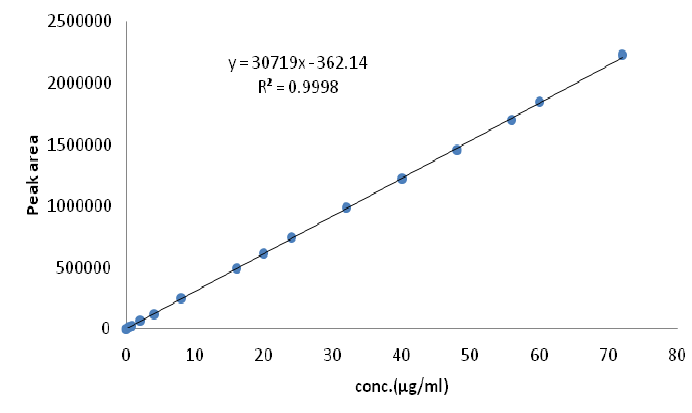
Figure 3. Calibration curve of Brimonidine by